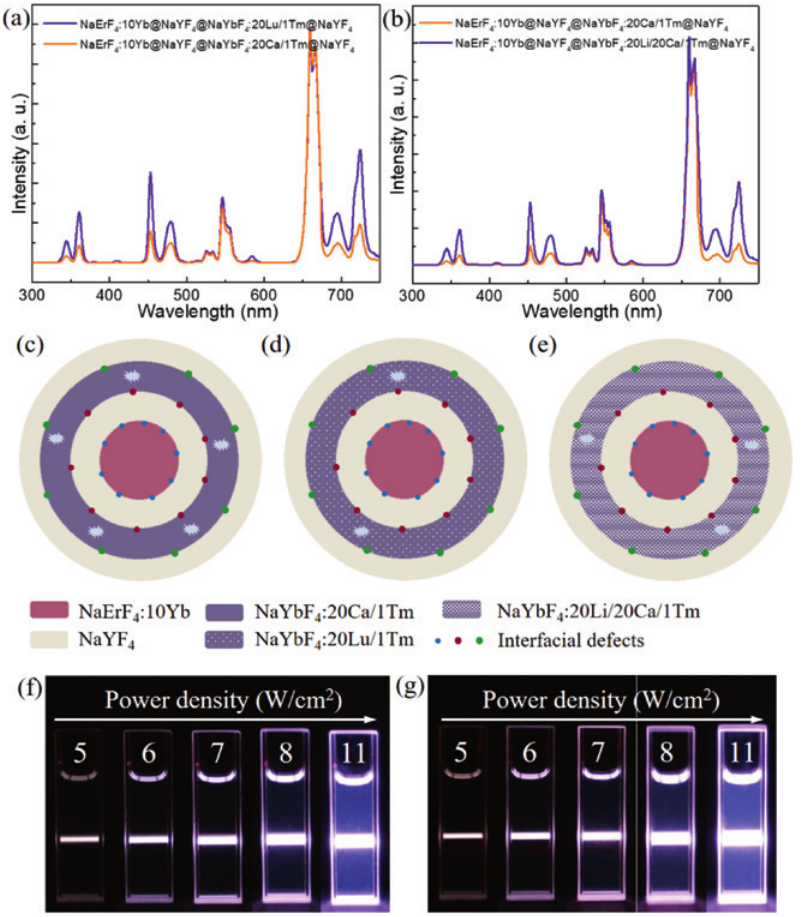
Figure 5: UC emission spectra of NaErF 4